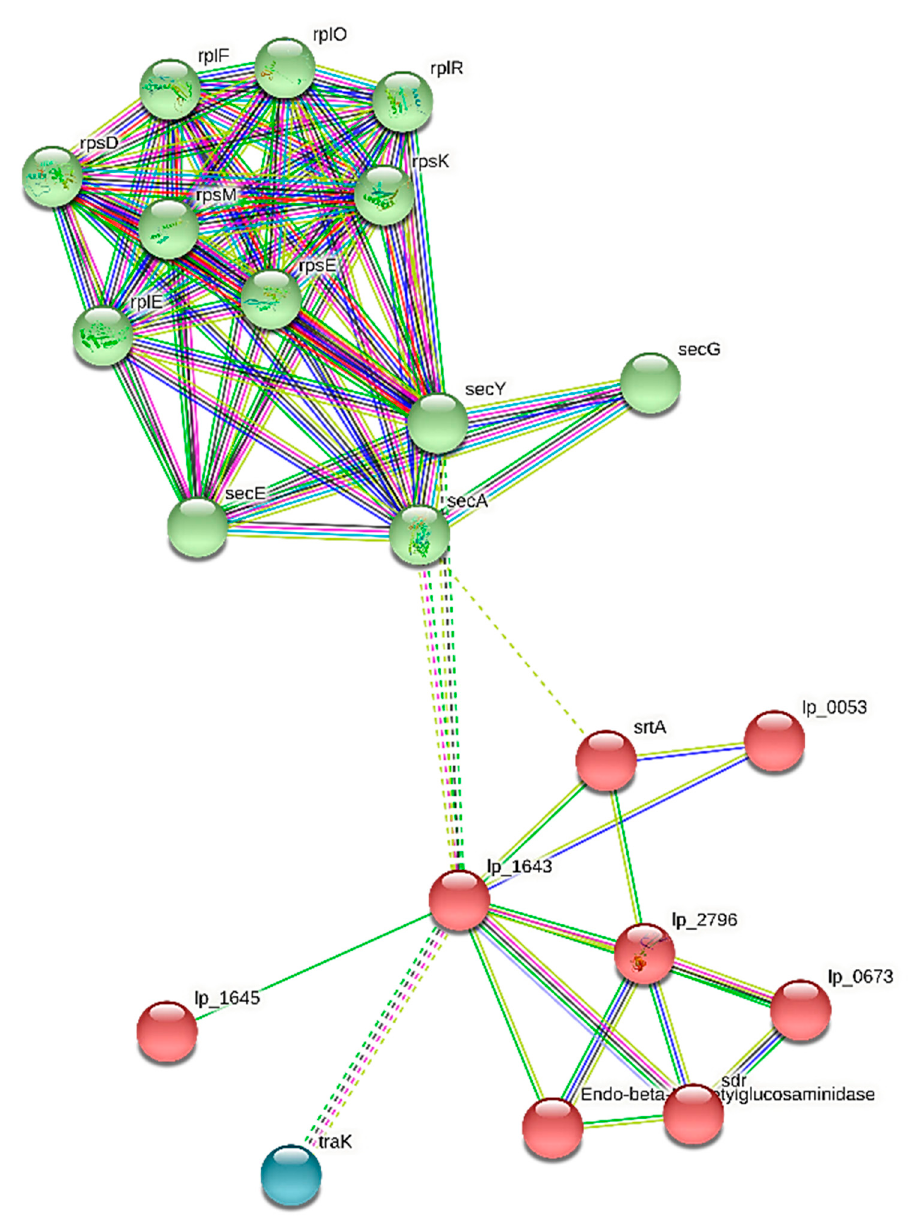
Figure 7. Protein–protein interaction of functionally annotated components of L. plantarum 13 ‐ 3 genome.